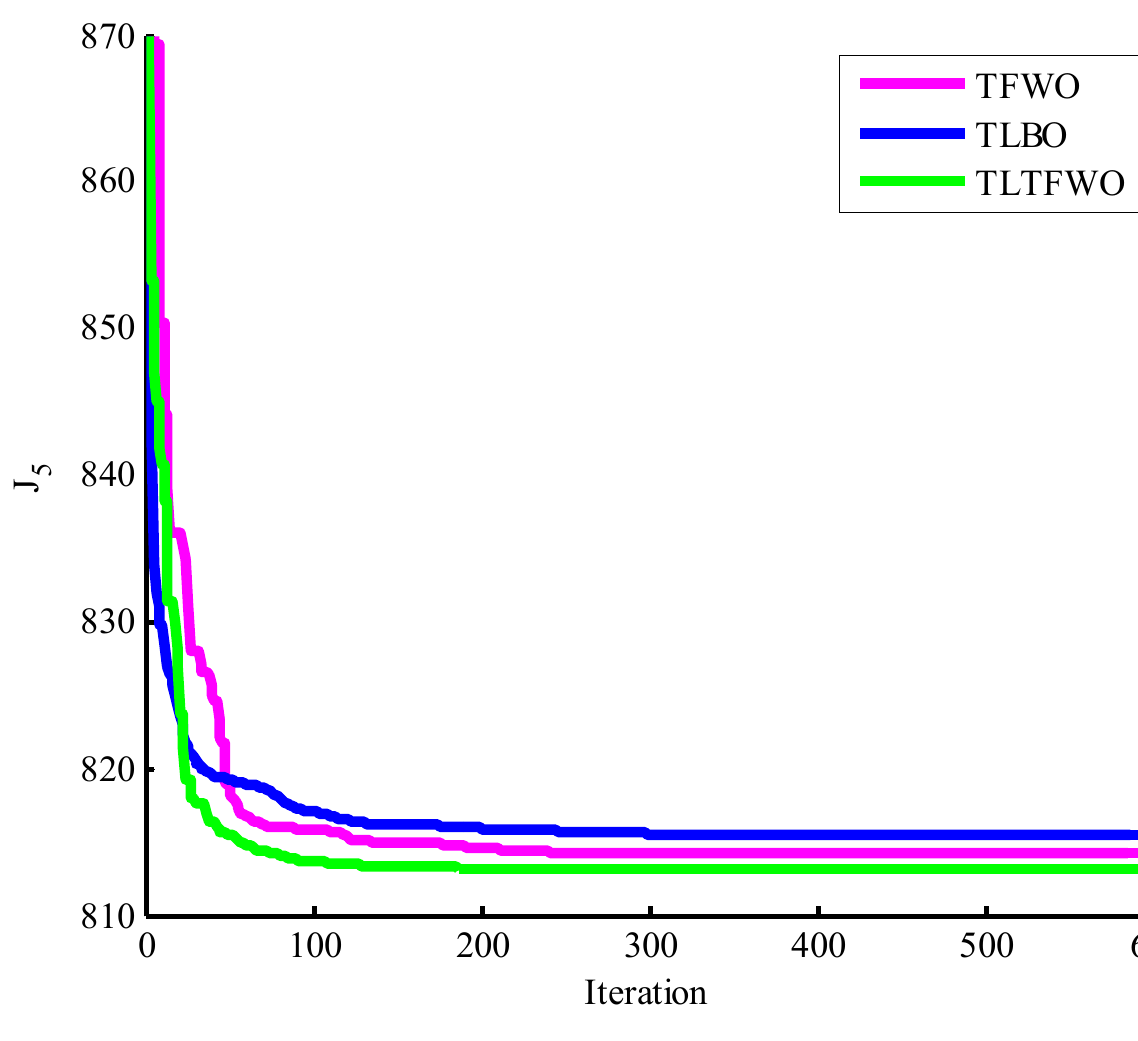
Figure 9. Convergence trends in Case 5.